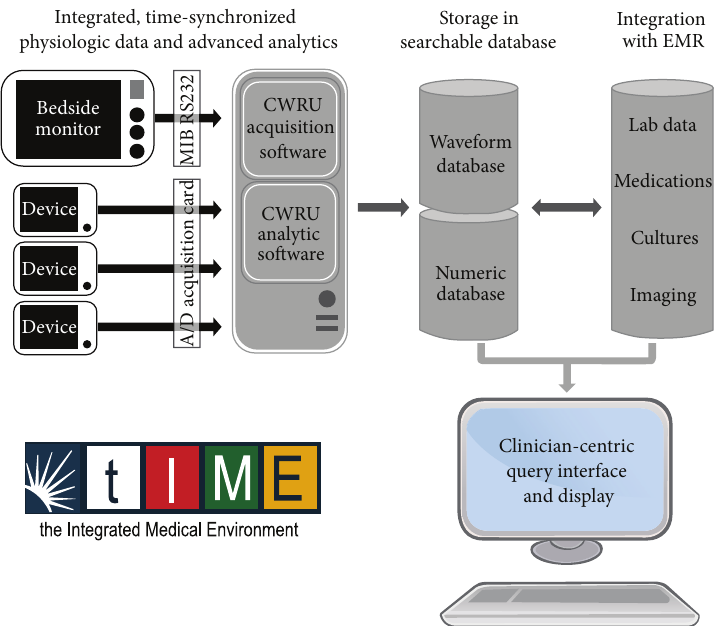
Figure 1: Schematic illustration of the integrated medical environment